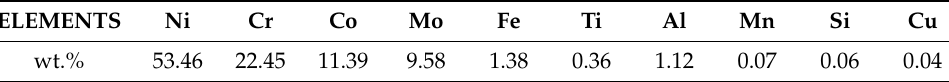
Table 1. Material composition of IN 617.